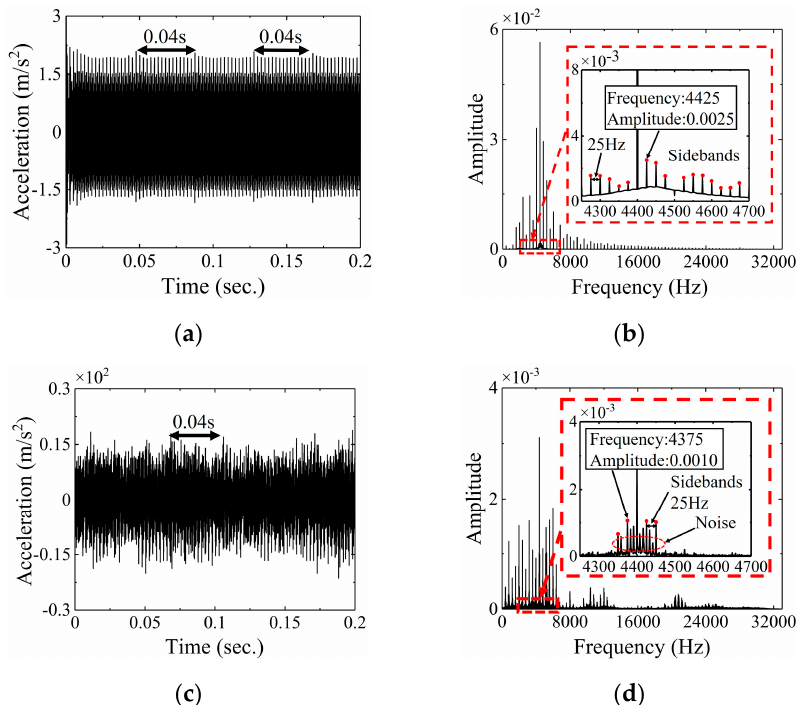
Figure 11. The simulated and experimental signal in the meshing line direction (single tooth with spalling fault): ( a ) simulated signal, ( b ) simulated frequency signal, ( c ) experimental signal, and ( d ) experimental frequency signal.